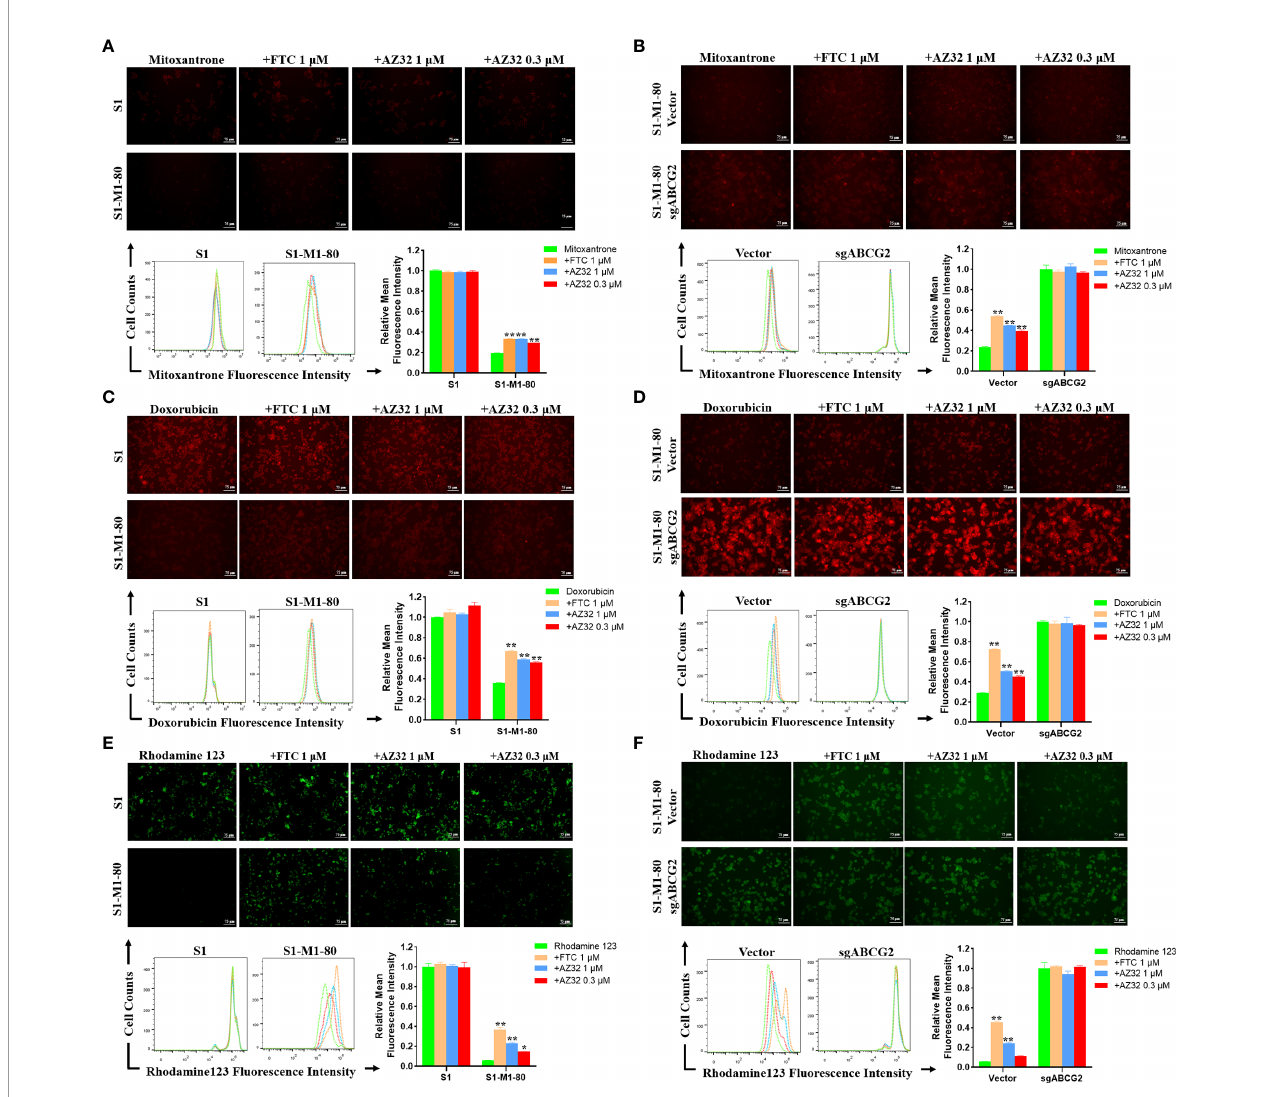
FIGURE 3 | AZ32 enhances the intracellular accumulation of ABCG2 substrates in ABCG2-overexpressing colorectal cancer cells. Cells were incubated with 10 m M mitoxantrone, doxorubicin or rhodamine 123 for another 2 h at 37°C after pre-treated with the indicated concentrations of AZ32 or FTC for 1 h at 37°C and photographed by fl uorescent microscope. Then the fl orescent intensity was measured by fl ow cytometer and quanti fi ed (A – F) . * P < 0.05, and ** P < 0.01 vs. corresponding